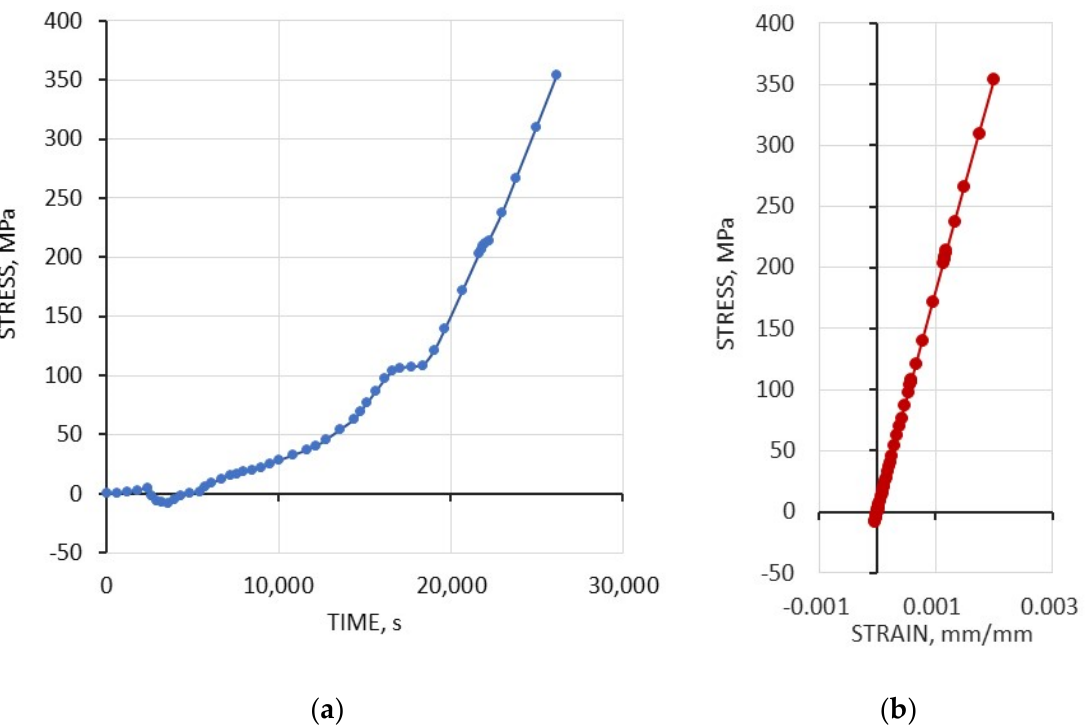
Figure 10. The ( a ) time versus stress and ( b ) stress versus strain relationships in the OR COLD startup scenario, under industrial operating conditions.